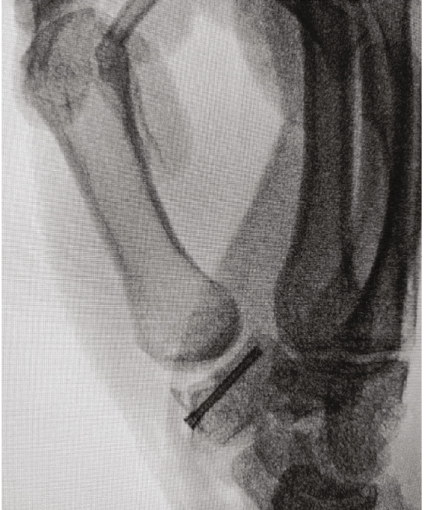
Figure 3: Fixation with 2 mm headless screw demonstrating excellent fi xation of fracture and congruity of the carpometacarpal